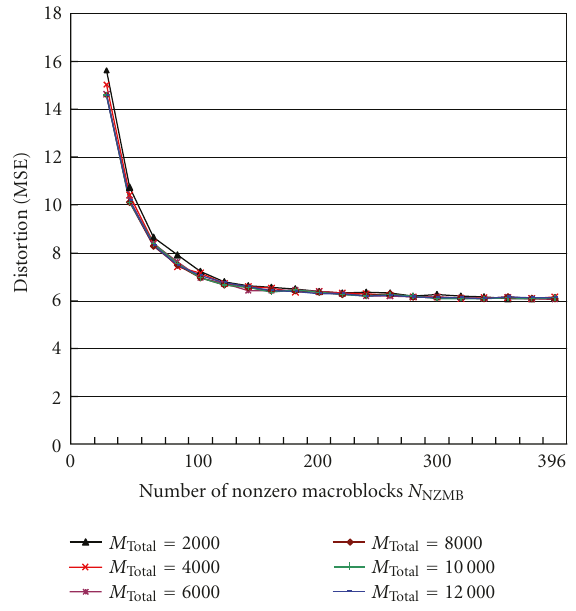
Figure 8: The distortions of the Container sequence for di ff er- ent numbers of nonzero macroblocks ( N NZMB ) and SAD operations ( M Total ).